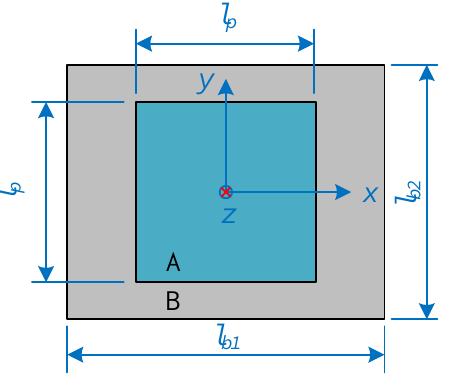
Figure 4. Top view of the basic unit of periodic shunted piezoelectric patches structure.